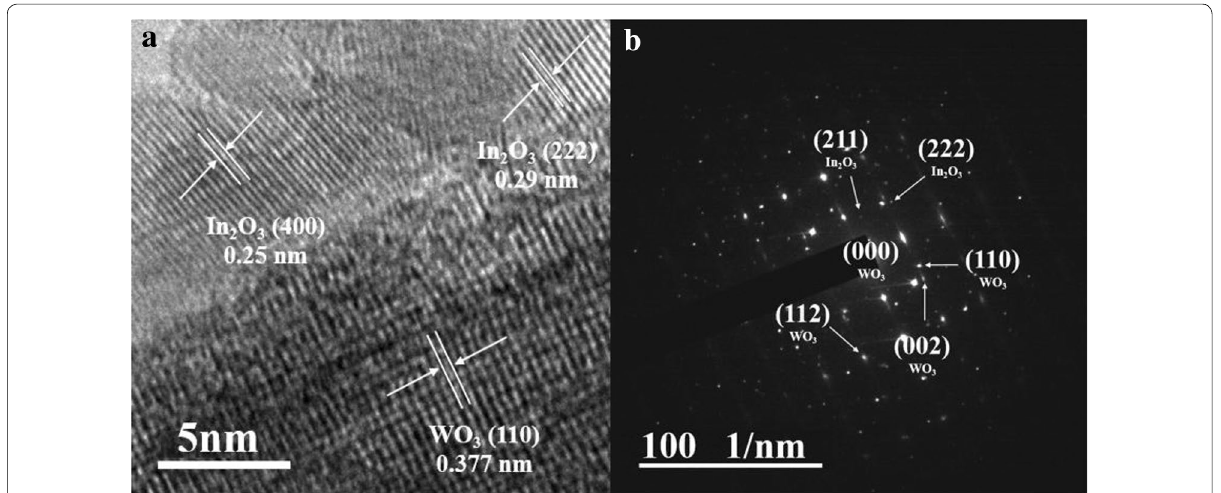
Fig. 3 a High‑resolution TEM image, b corresponding electron diffraction pattern of the In 2 O 3 NPs‑decorated WO 3 NRs